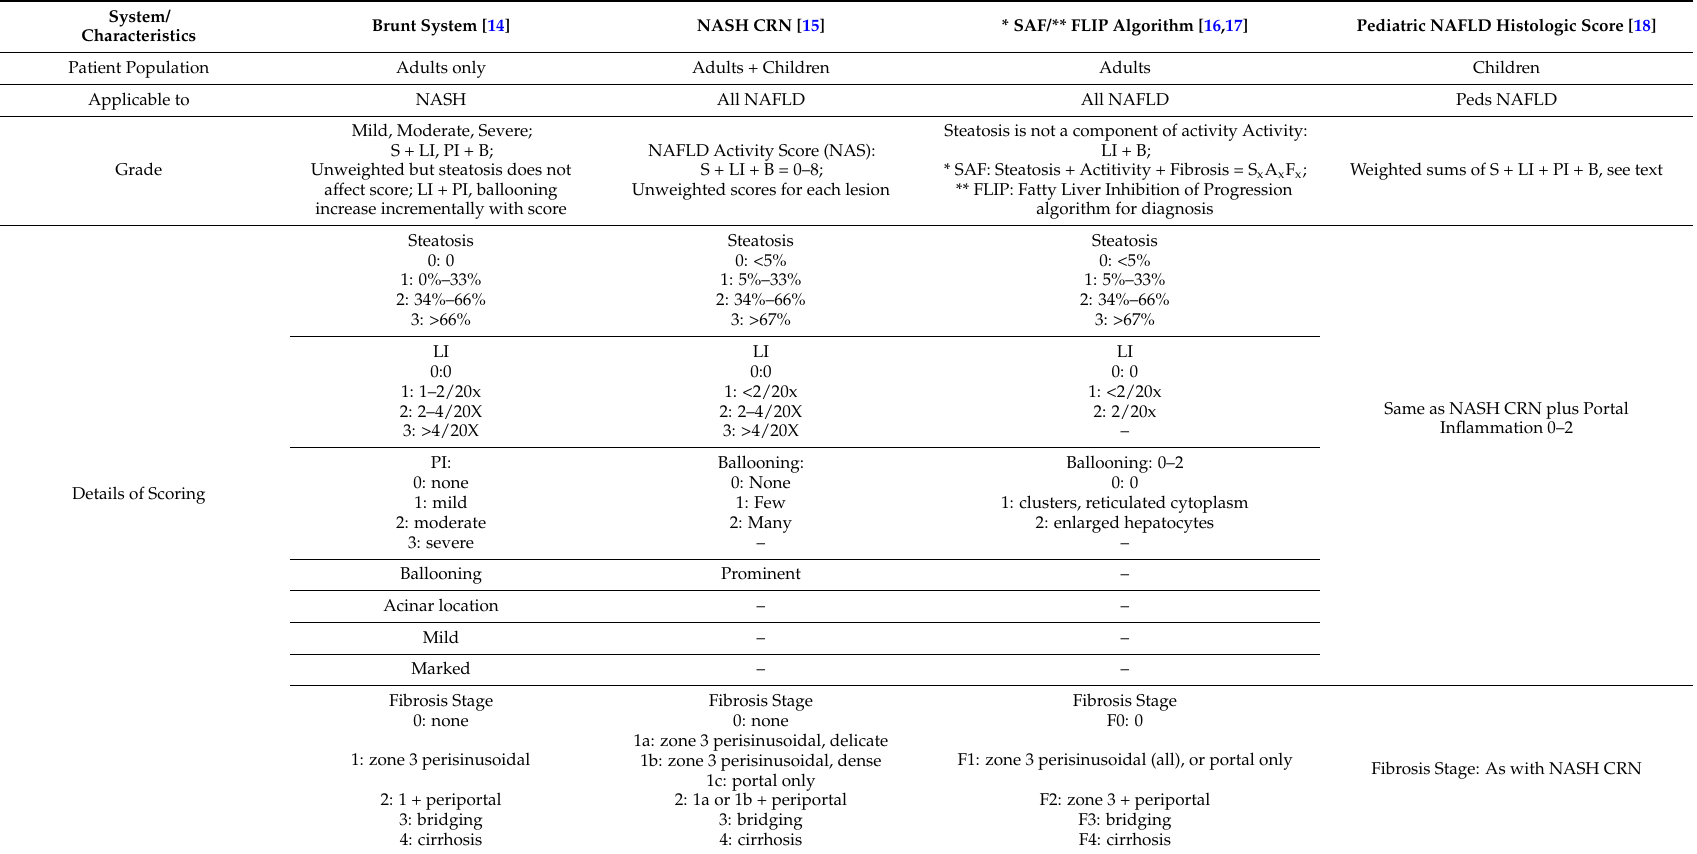
Table 1. Histologic methods of semi-quantitative evaluation of nonalcoholic fatty liver disease (NAFLD).